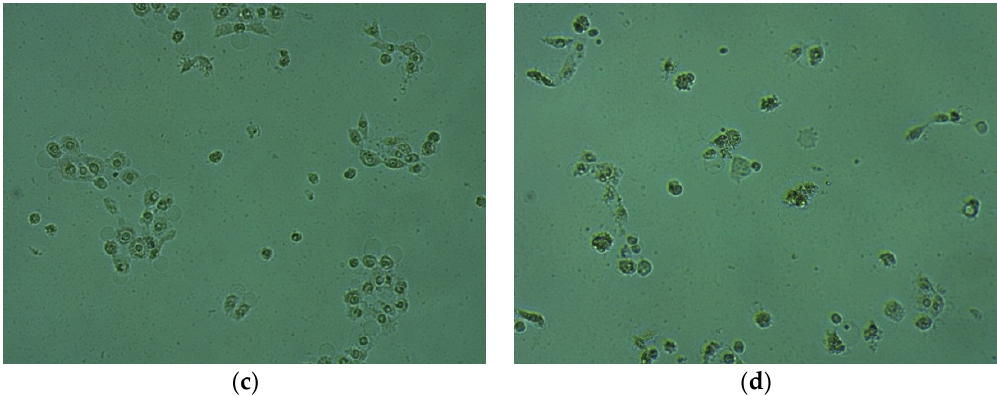
Figure 3. Morphological changes of HaCaT cells after 24 h treatment with compounds 11 , 13 and 25 , observed under the light microscope (800×): Untreated cells ( a ). Cells treated for 24 h with compounds 11 , 13 and 25 in concentrations 8 µM, 8 µM and 37 µM, respectively ( b – d ).